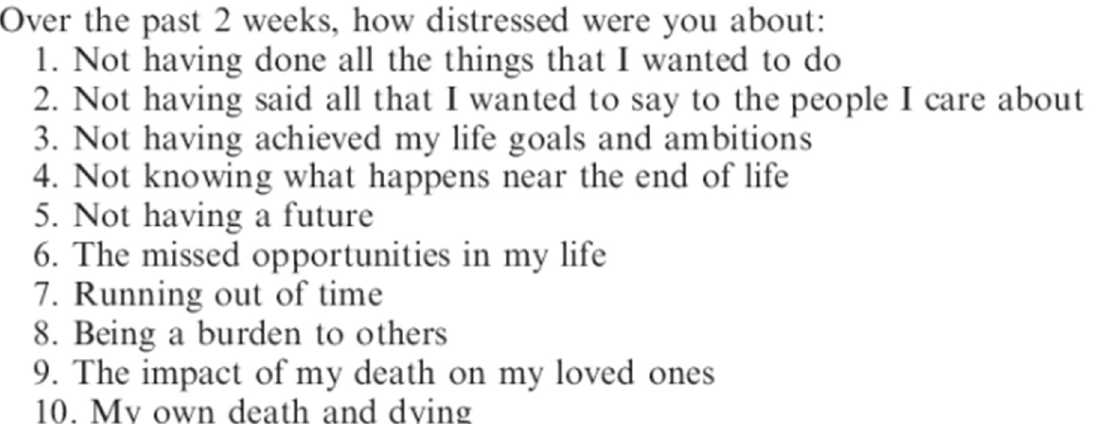
Figure 4. Sample Items from Lo et al.’s Death and Dying Distress